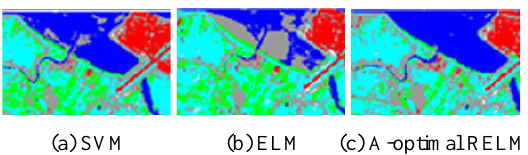
Table 9. Confusion matrix of A-optimal RELM on Hamburg image experiment